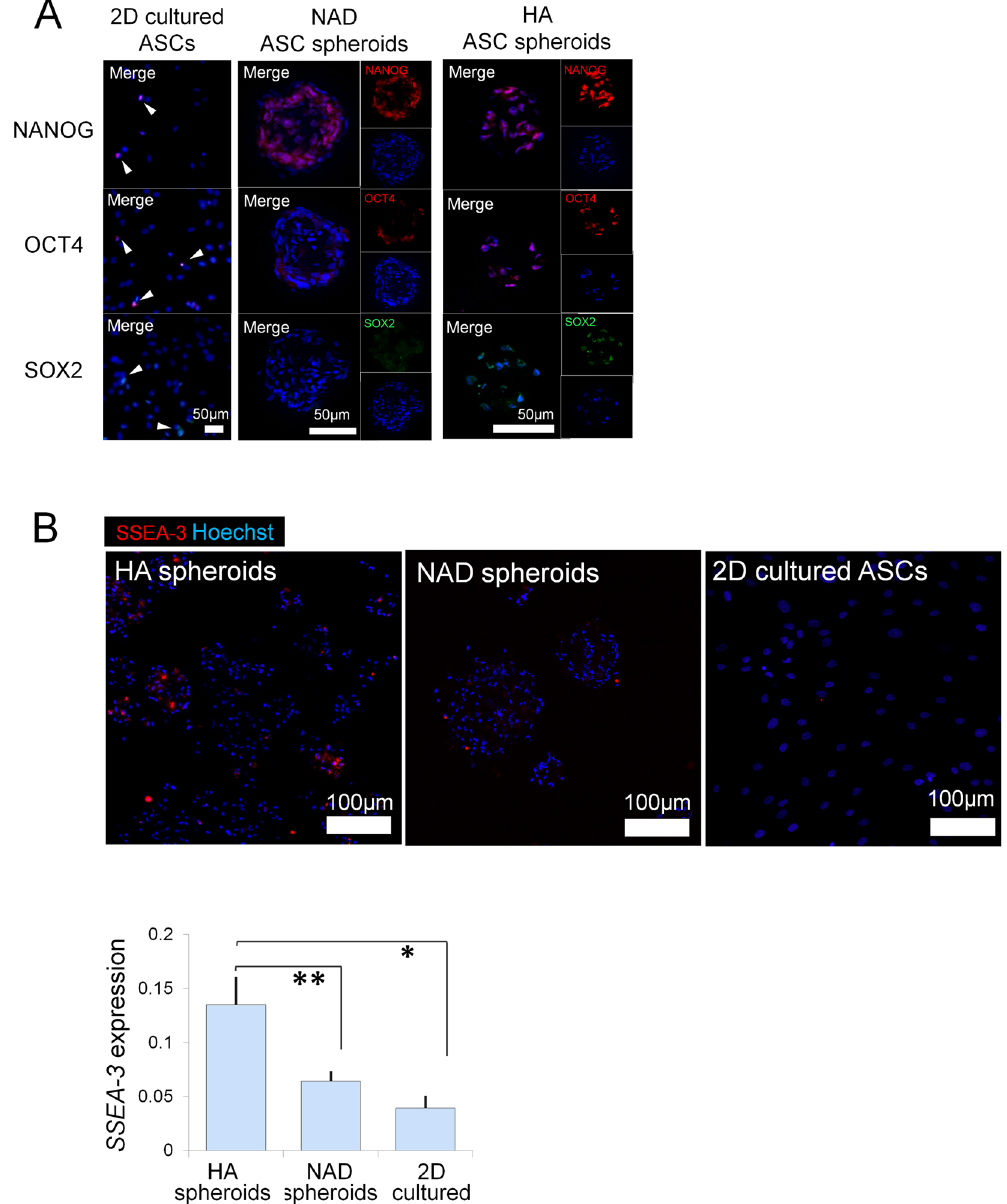
Figure 3. Stem cell marker expression of spheroids. ( A ) Immunohistology for nuclear stem cell markers, NANOG , OCT4 and SOX2 , in ASCs after 12 h culture on 2D petri dish, non-adhesive dish, and HA gel. Nuclei were labeled with Hoechst (blue). Scale bars = 50 µ m. ( B ) SSEA-3 expression in ASCs 12 h after seeding on 2D petri dish (2D), non-adhesive dish (NAD), and in HA gel (HA). Bar graph showed the relative quantification of the SSEA-3 fluorescence. p = 0 . 019 , * , ** p < 0.05; n = 3 independent experiments. Scale bars = 100 µ